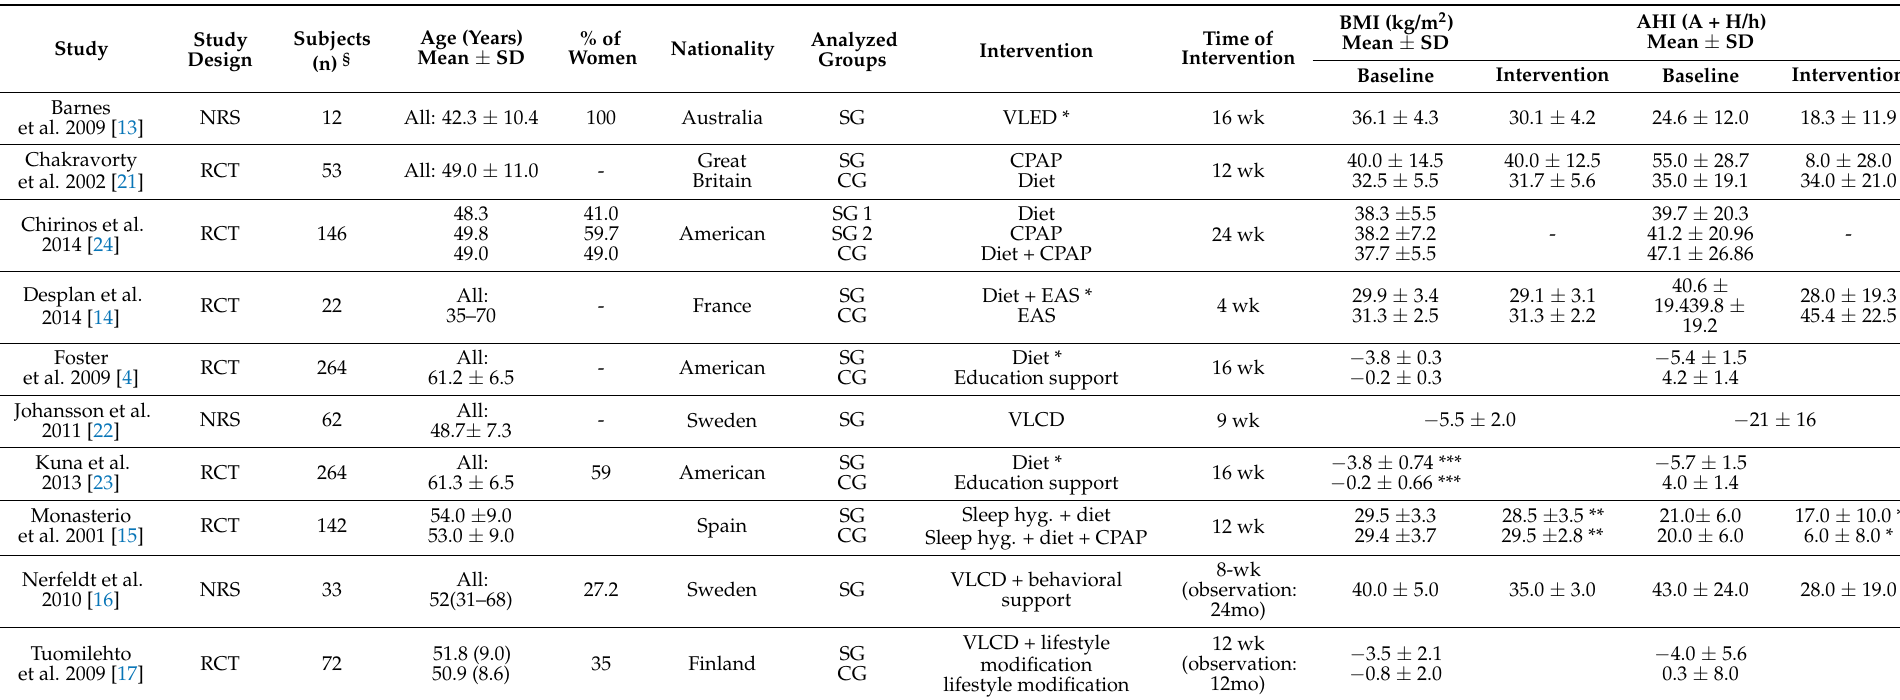
Table 1. Characteristics of the included studies and changes in BMI and AHI during dietary intervention in the study and control